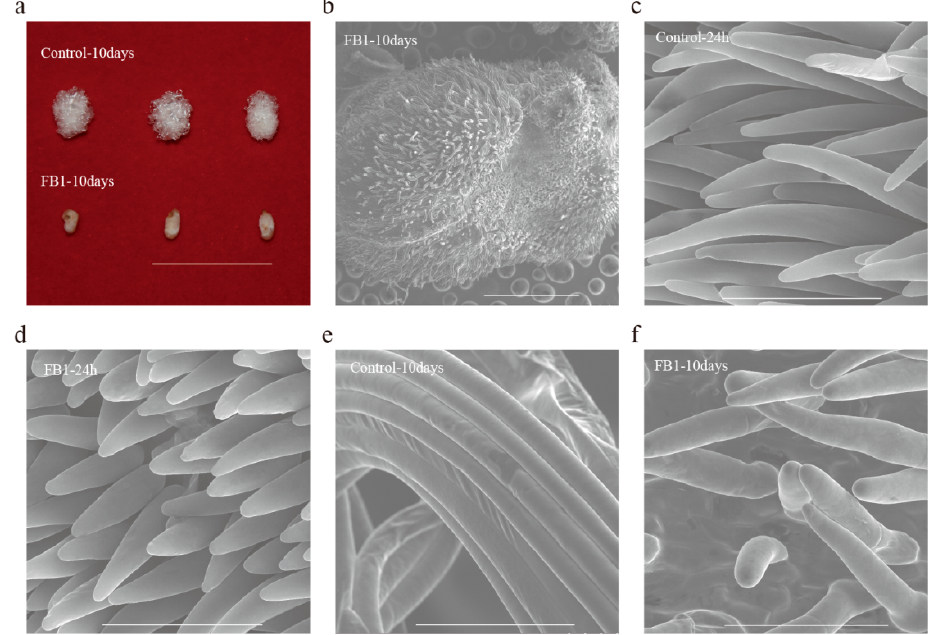
Figure 1. The elongation of cotton fiber is blocked by the sphingolipid synthesis inhibitor FB1. ( a ) WT ovules were collected at 2 DPA and cultured for 10 days in the culture media with DMSO or FB1, bar = 2 cm. ( b ) Scanning electron microscopy of FB1 sample cultured for 10 days, bar = 1 mm. ( c , d ) Scanning electron microscopy of the control ( c ) and FB1 sample ( d ), cultured for 24 h, bar = 100 µ m. ( e , f ) Scanning electron microscopy of the control ( e ) and FB1 sample ( f ) cultured for 10 days, bar = 100 um.